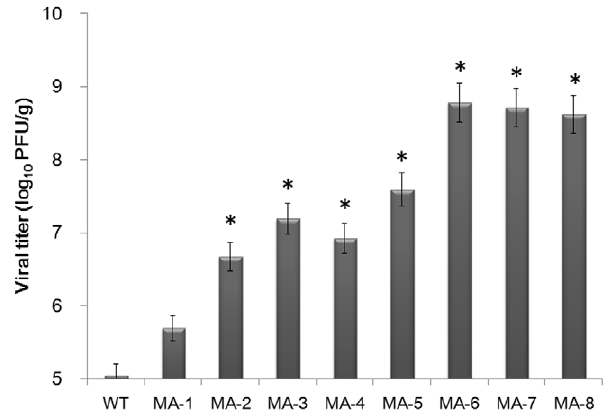
Figure 1. Adaption process of each passage of mouse-adapted seasonal H1N1 A/Brisbane/59/2007 viruses in mouse lungs. BALB/c mice were infected with wild-type virus and three days later, their lungs were dissected out to generate the first passage of mouse- adapted virus (MA-1). Subsequently, the lung lysates were used for infection of mice to generate MA-2, which was subjected serial mouse lung passages (total of eight passages). The replication of each passaged virus was determined as viral titers in the lungs. Data are expressed as mean 6 SD of viral titers (log10 PFU/mg) in the lungs of each group of mice (n=3 per group) from three separate experiments. * P , 0.05 vs. the values of wild type virus. doi:10.1371/journal.pone.0028901.g001 PLoS ONE |